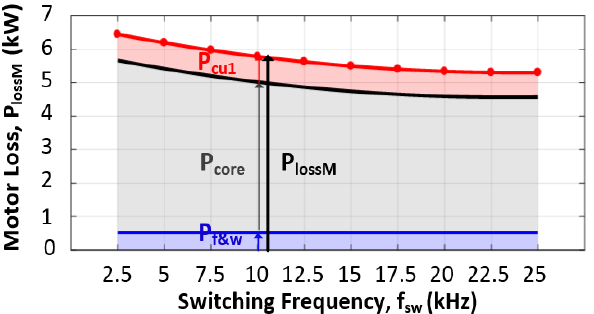
Figure 11. Variations in total power loss components of the traction motor at no-load against switching frequency of the inverter when V dc = 750 V, V s = 480 V l-to-l, f s = 60 Hz, and n r = 1800 rpm.